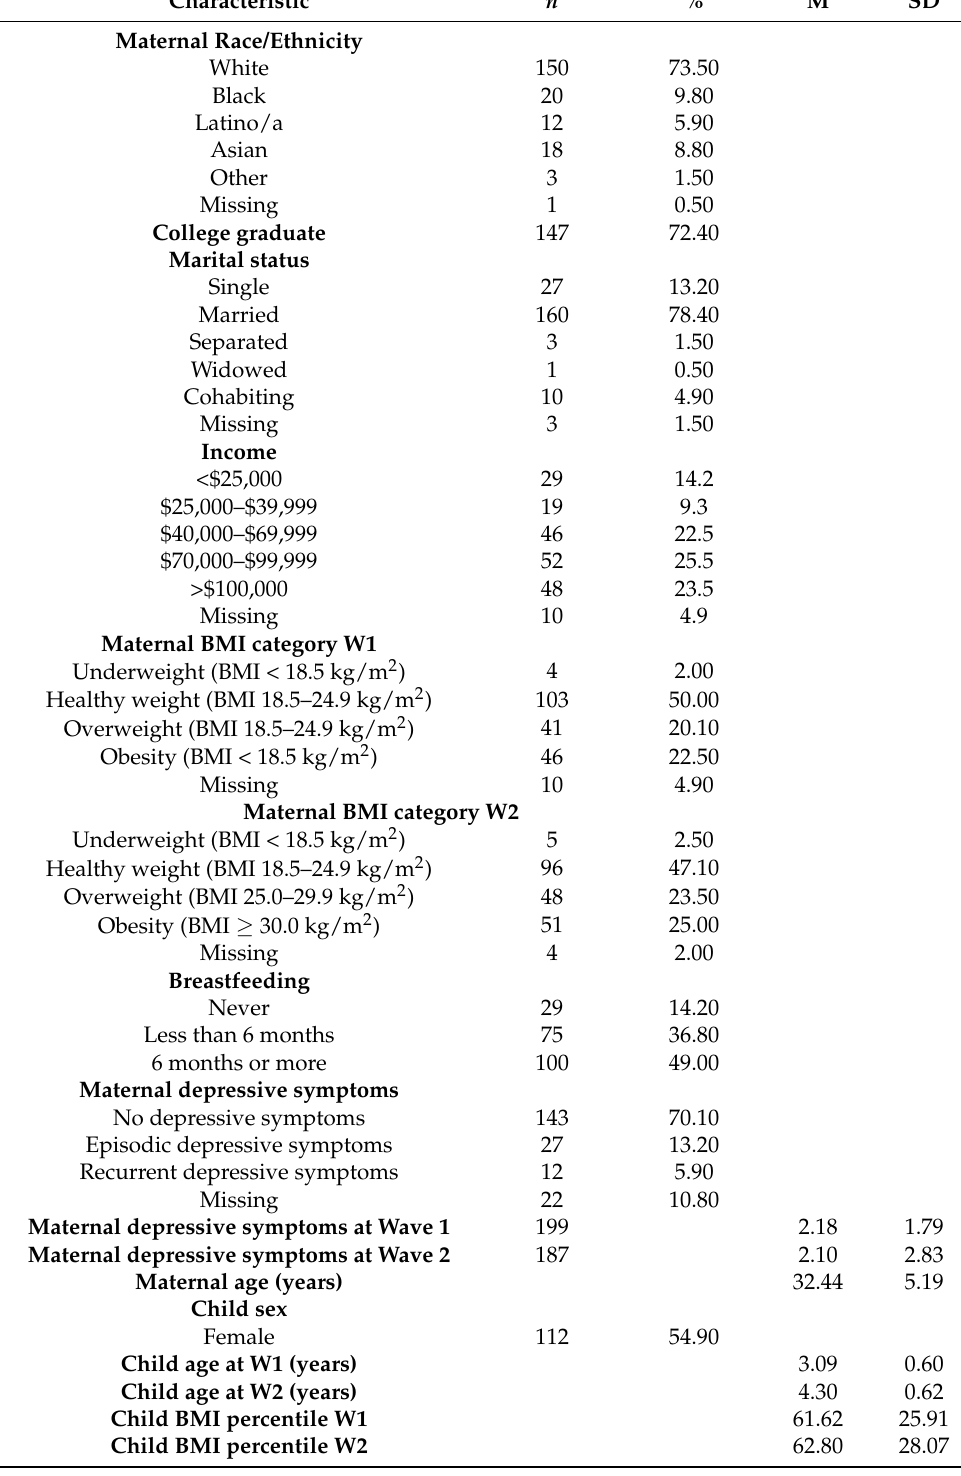
Table 1. Demographic Characteristics of Participants ( n =